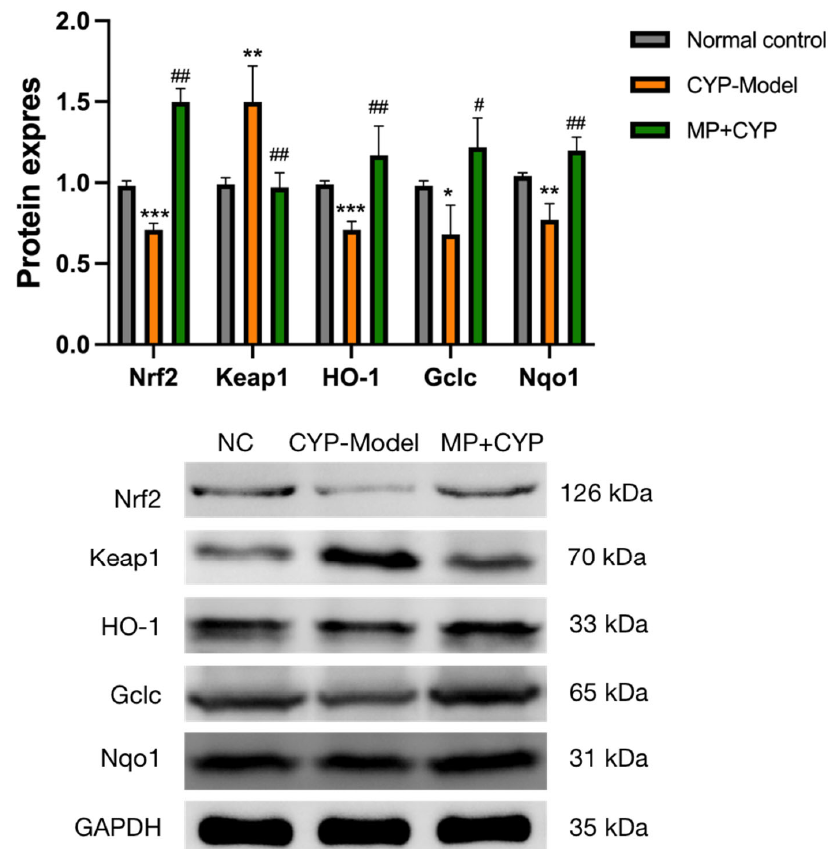
Figure 15. Effect of Maca polysaccharide on protein expression of Keap1 ‐ Nrf2 signaling in CYP ‐ treated mice ( n = 3). Protein expression of Nrf2, Keap1, HO ‐ 1, Gclc, and Nqo1 in the liver. * p < 0.05, ** p < 0.01, *** p < 0.0001 compared with Normal Control group; # p < 0.05, ## p < 0.01 compared with CYP Model group. Data are expressed as means ± SEM.